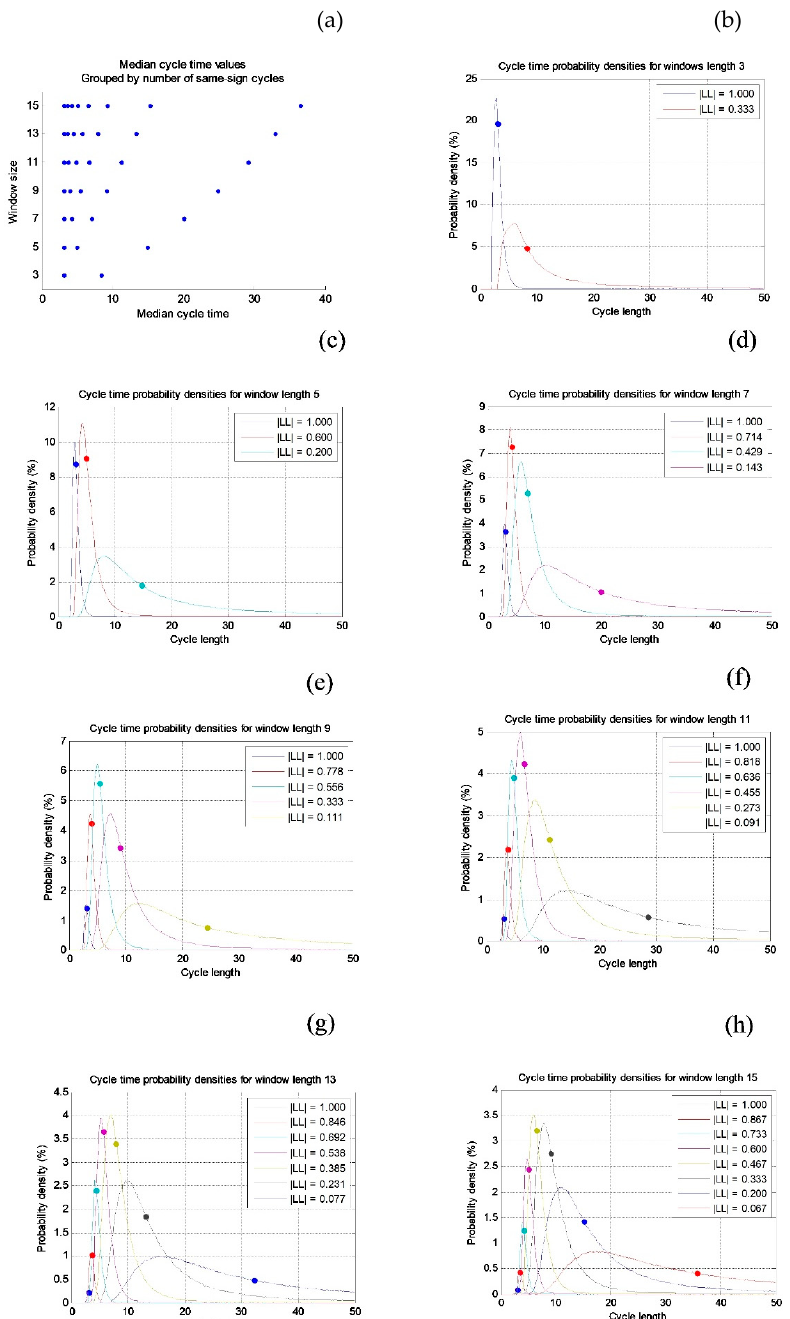
Figure 4. Median cycle time grouped by window length (three to 15 observations) and increasing degree of persistent leading–lagging relation. ( a ) Median cycle time ( x -axis) and window size ( y -axis), increasing LL strength gives longer cycle times. ( b )–( h ) Probability frequency for window sizes 3 to 15 based on 100,000 simulations using random series of length